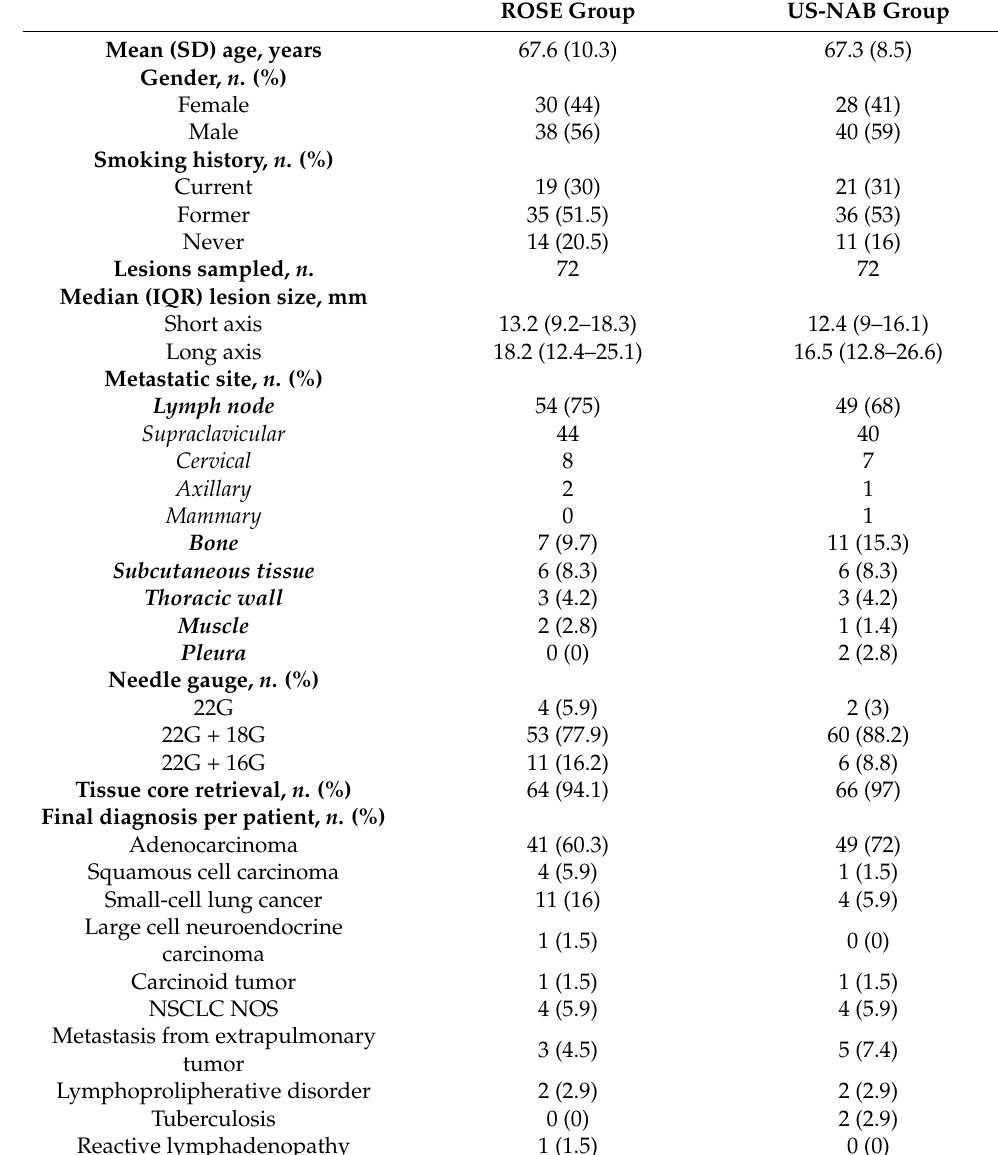
Table 1. Demographics and baseline characteristics of the patients (136) and lesions (144). ROSE